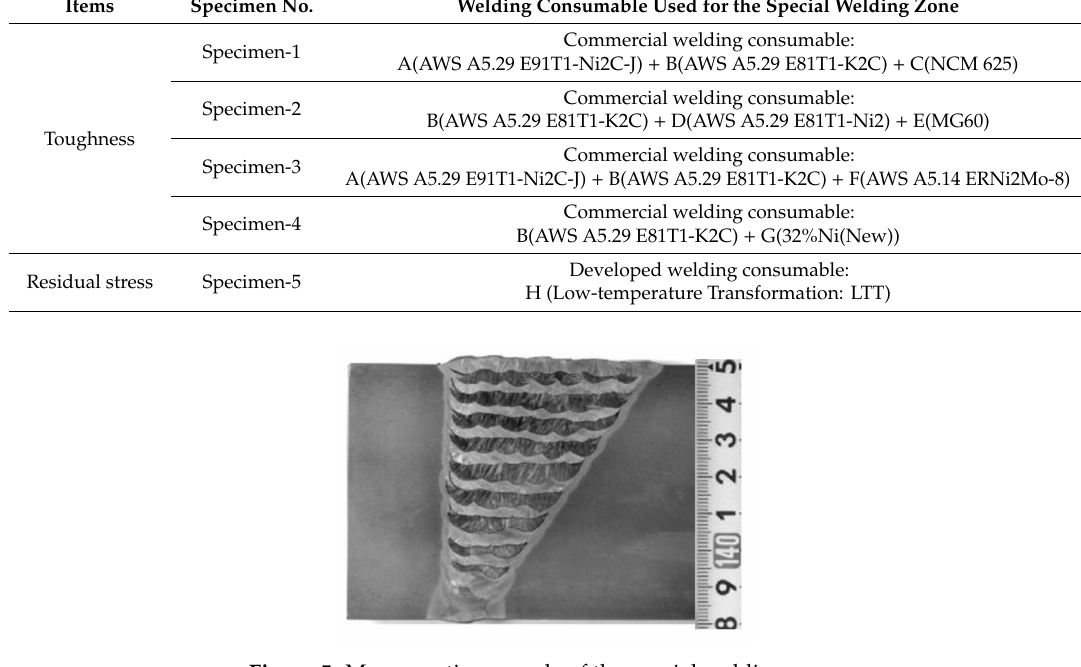
Figure 5. Macro-section sample of the special welding